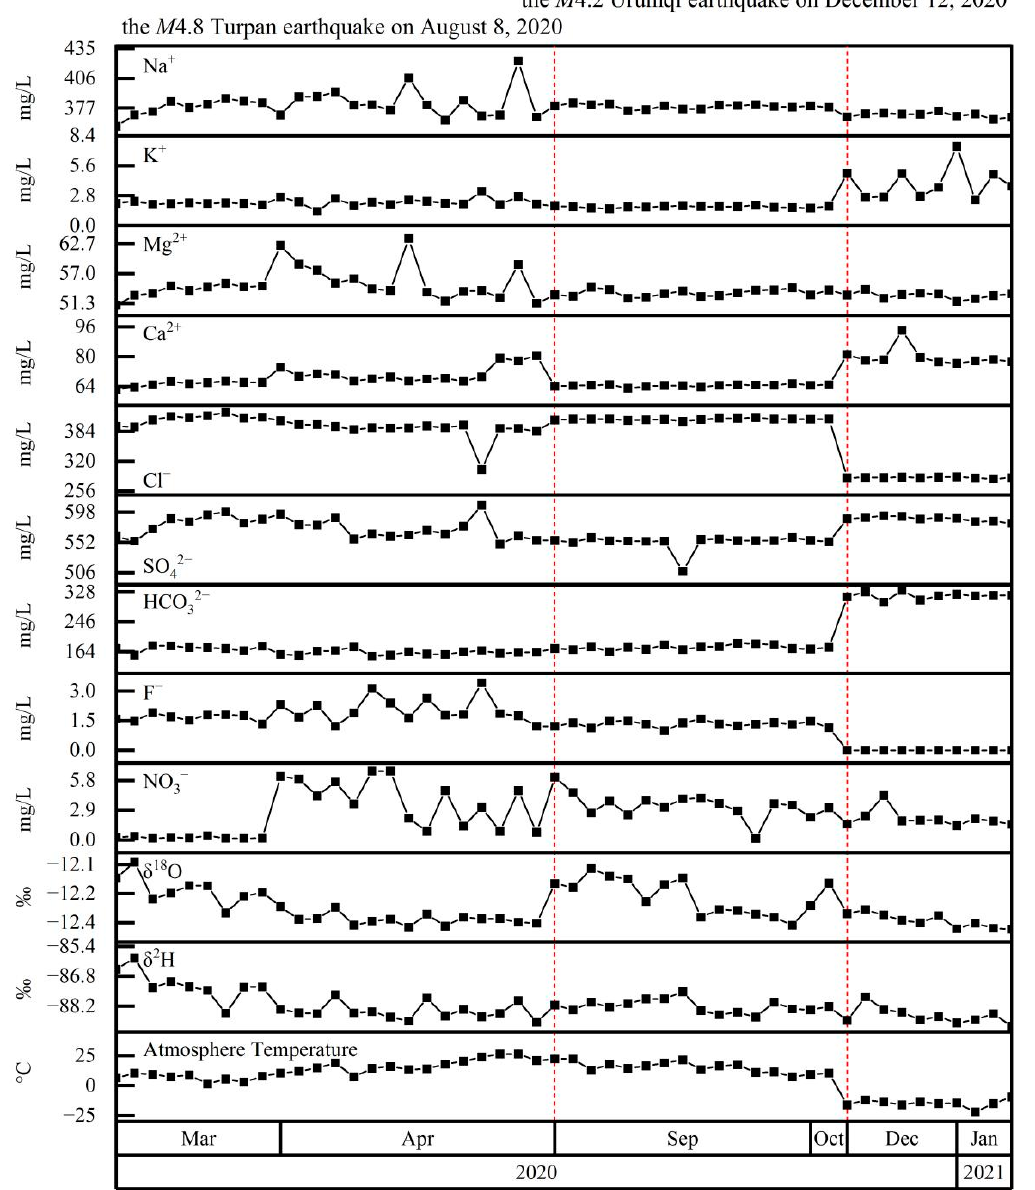
Figure 5. Time series of Spring 10 major ion concentrations (Na + , K + , Mg 2+ , Ca 2+ , Cl − , SO 42 − , HCO 3 − , F − , and NO 3 − ), stable isotopes ( δ 2 H, δ 18 O), and atmospheric temperature. Red-dashed lines mark the occurrence of potentially significant earthquakes within the study area.